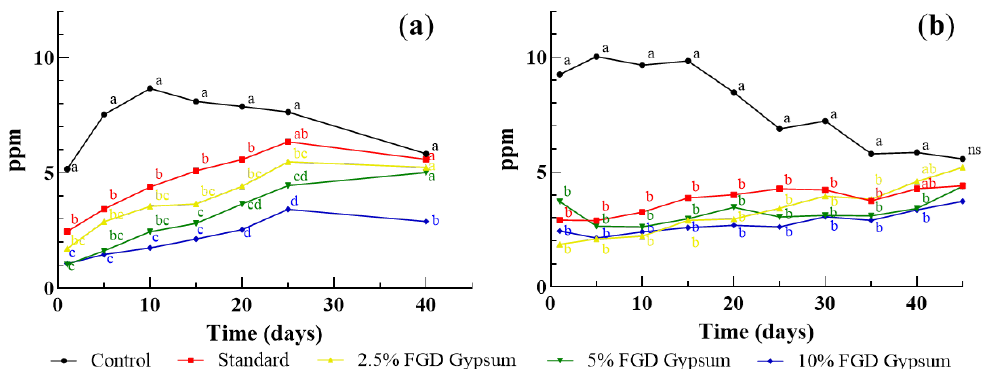
Figure 2. The effect of substrate amendments on total P leaching over time in daily irrigated pine bark columns container conducted in ( a ) 2021 and ( b ) 2022. Substrate treatments consisted of neither dolomitic limestone nor flue gas desulfurization (FGD) gypsum (Control), 4.15 kg m − 3 dolomitic limestone (Standard), dolomitic limestone and 2.5% ( v / v ) FGD gypsum, dolomitic limestone and 5% FGD gypsum, or dolomitic limestone and 10% FGD gypsum. Due to mishandling of samples in 2021, data for Day 30, 35, and 45 were unrecovered. All reported values are lsmeans. Treatment effects were analyzed using Tukey ’ s honest significant difference by day. Values containing the same letter were not significantly different ( p > 0.05).